Question: Does the figure show an increasing or a decreasing trend?
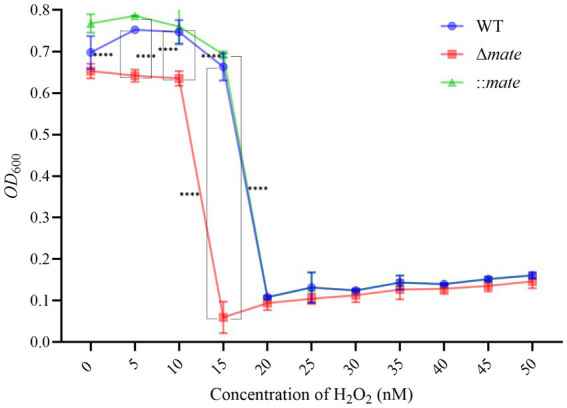
Answer: increasing